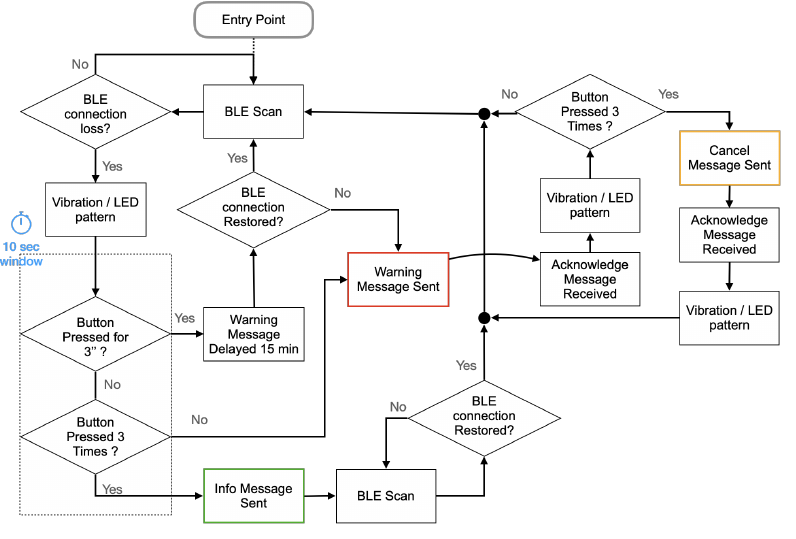
Figure 12. PPE worn check,